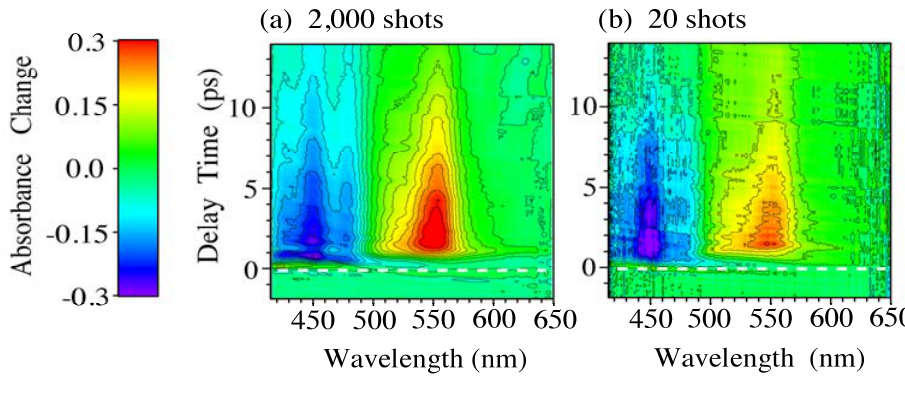
Figure 4. Time-frequency 2D image of transient absorbance changes of β -carotene in n -hexane solution mapped by the time-frequency 2D pump-probe imaging spectroscopy with accumulations of (a) 2,000 and (b) 20 laser shots